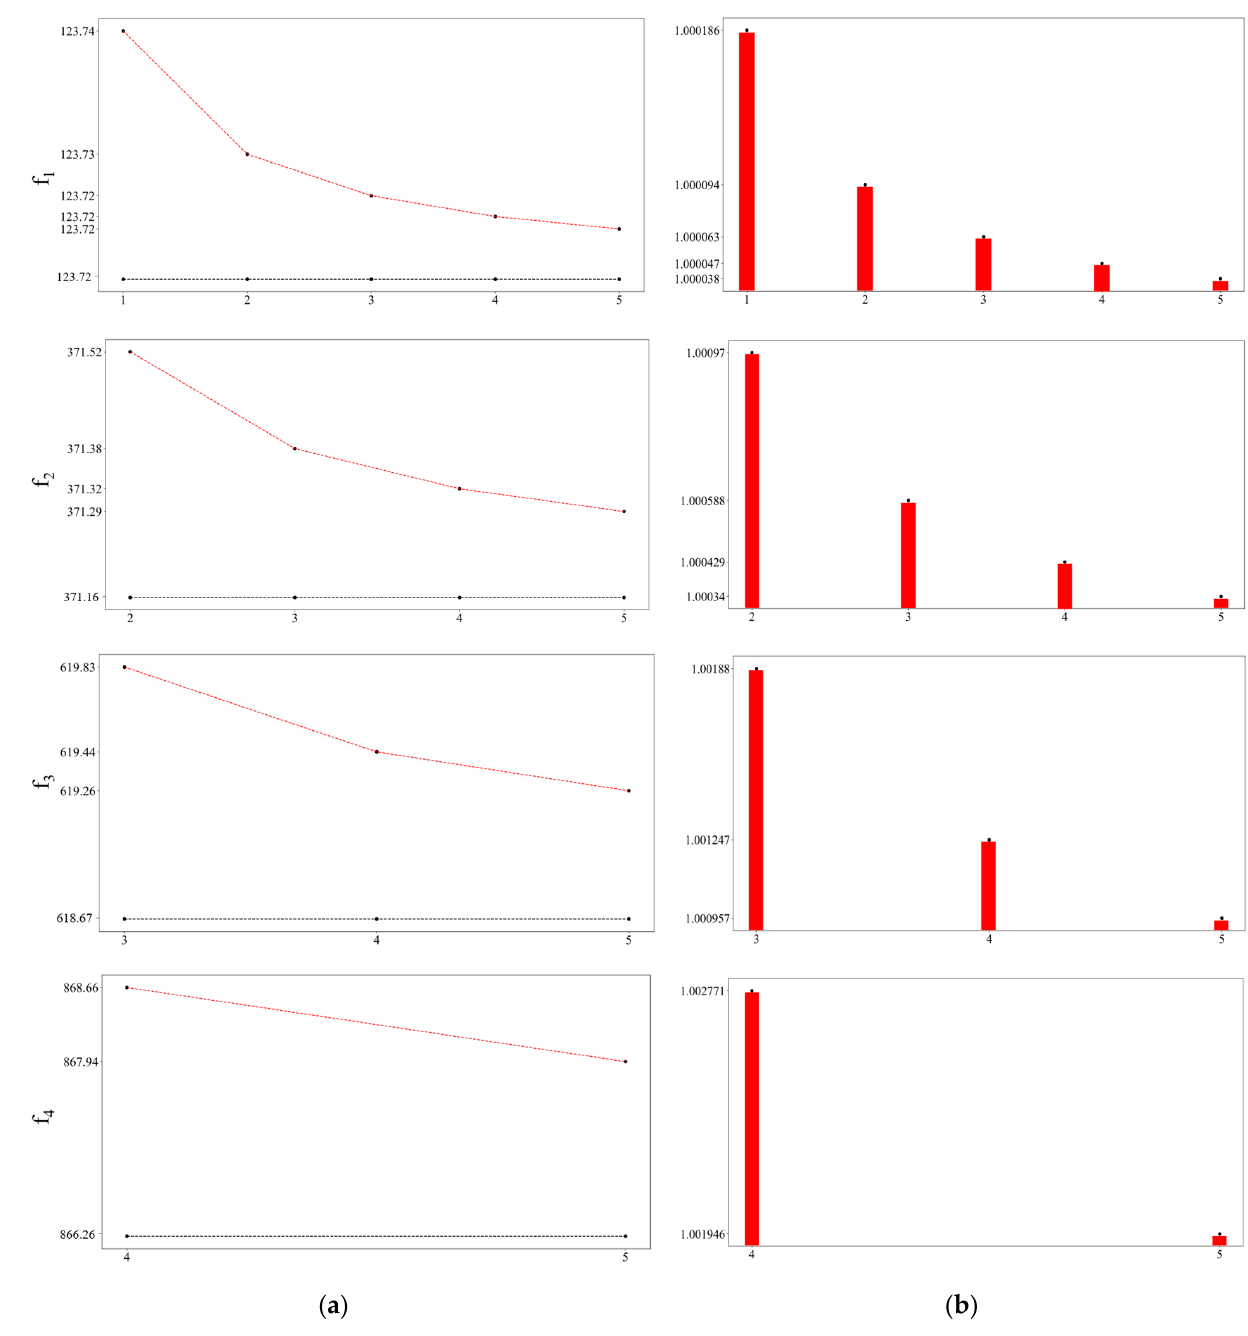
Figure 3. The first four eigenfrequencies of the pylon with an attached transient mass for mass ratio R = 0.02 and at time t = 0: ( a ) Left column plots the eigenfrequencies as the number of iterations increases (red color) and the exact values (black color) ( b ) Right column plots the corresponding rate of convergence.